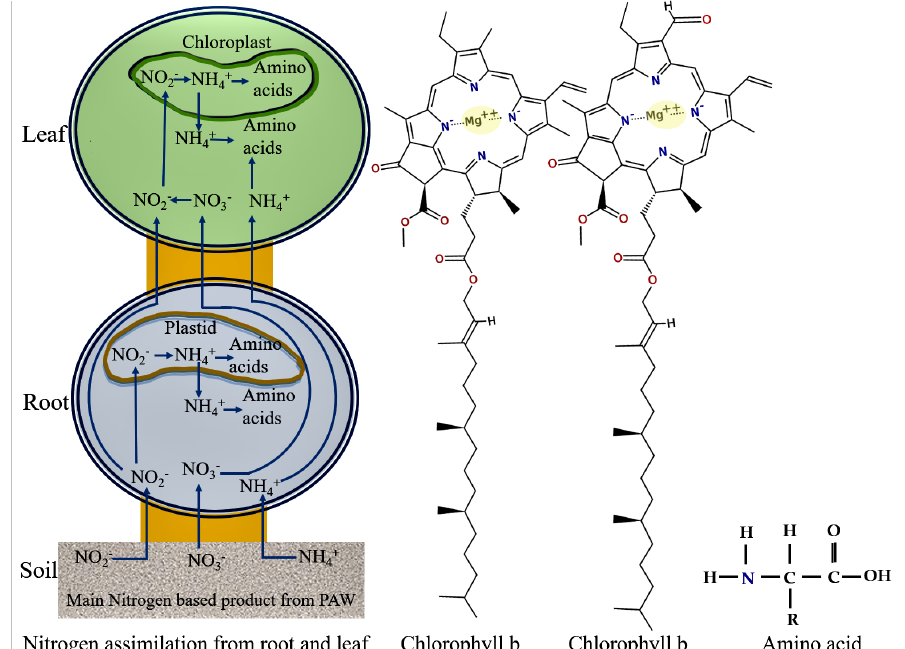
Figure 11. Schematics showing general nitrogen assimilation in the roots and leaves of plants and the chemical structures of chlorophyll and amino